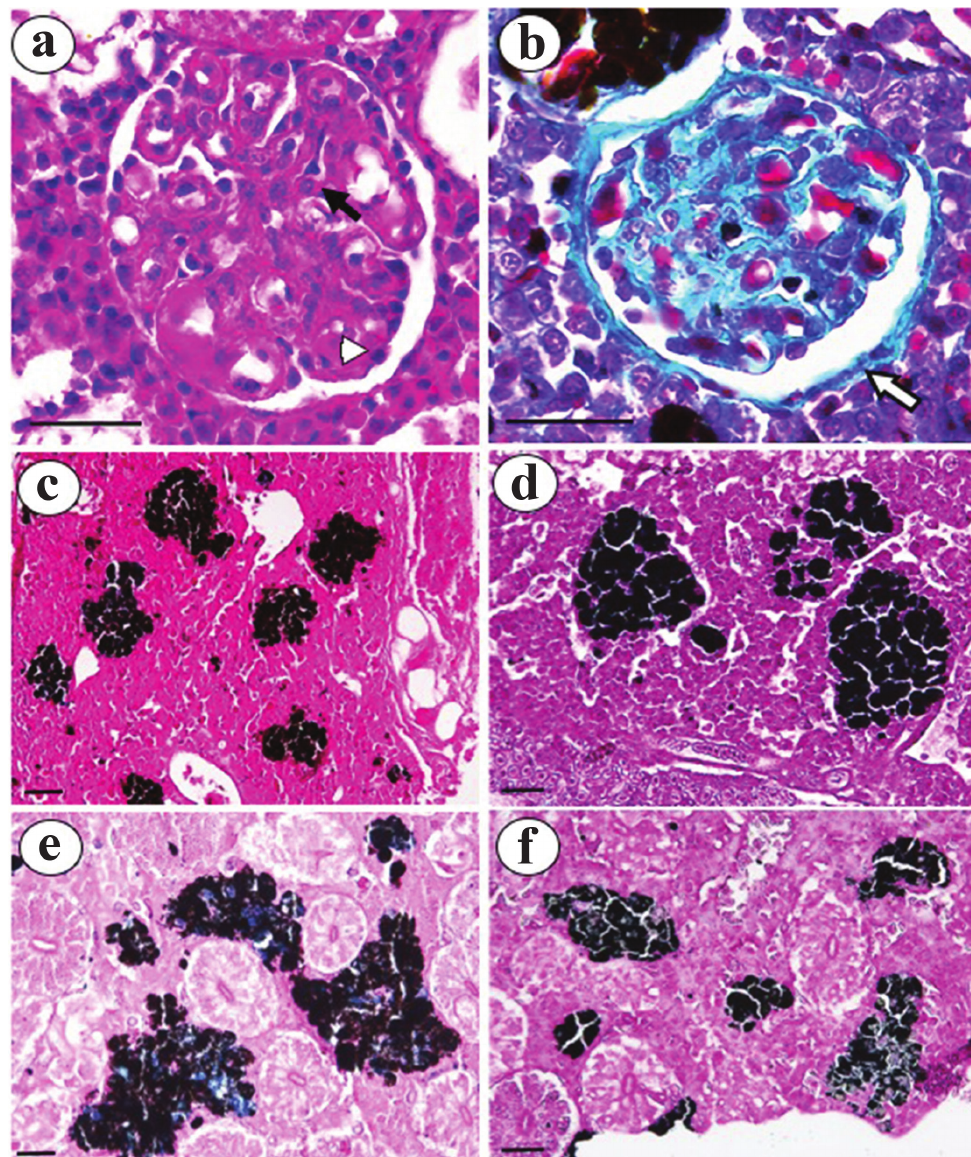
Fig. 3. Histological cross-sections and histochemical reactions to hemosiderin and lipofuscin in the kidney tissue of Gymnotus inaequilabiatus . a. typical architecture of renal corpuscle with central vascularized area characterized by a clump of capillaries closed to mesangial cells (black arrow) and podocytes (white arrowhead) surrounded by Bowman’s capsule; HE, bar scale = 10 µm. b. the glomerular capsule encloses the outer fibrous layer (white arrow) and filled by connective tissue. Red cells are inside capillaries; TM, bar scale = 10 µm. c–f. MMCs stained with ferrocyanide acid solution to hemosiderin and Schmorl´s solution to lipofuscin. c. melanin predominance in the head kidney MMCs. d. slight labeling to lipofuscin in the head kidney MMCs. e. positive labeling to hemosiderin (blue color) conjoined to the melanin deposits in the exocrine kidney. f. positive staining to lipofuscin (grayish blue color) in the exocrine kidney; Bar scale = 25